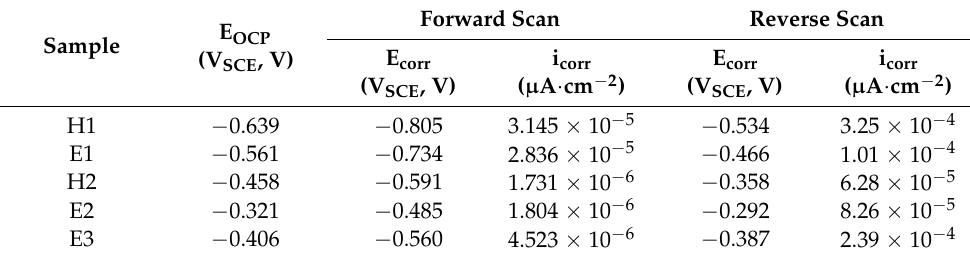
Table 5. Electrochemical results of OCP and potentiodynamic polarization.